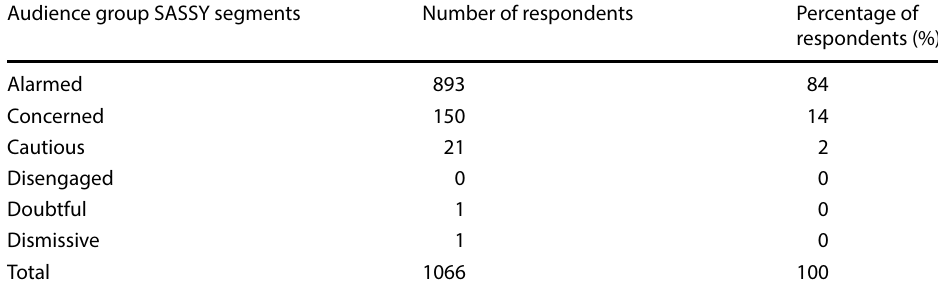
Table 3 Results of audience segmentation